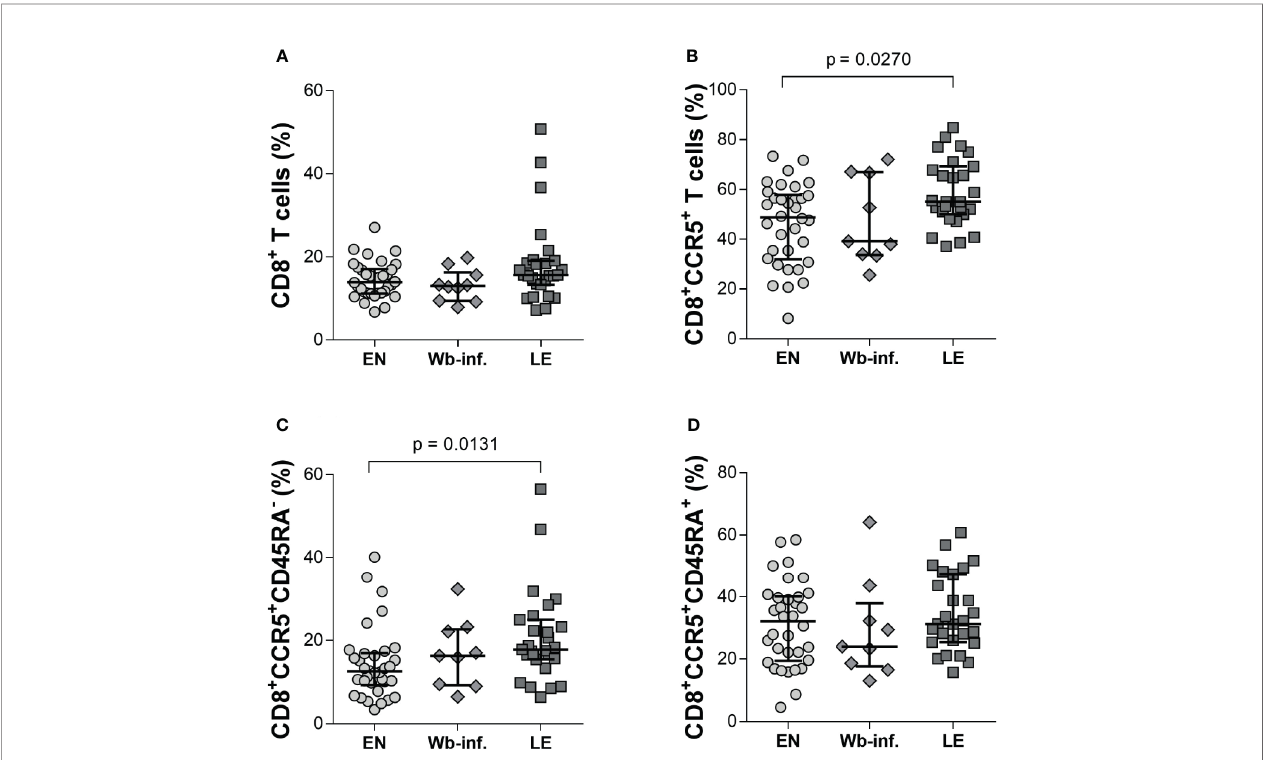
FIGURE 1 | CD8 + T cells from individuals with Wuchereria bancrofti-associated lymphedema present elevated expression of CCR5 + CD45RA - . Frequencies of CD8 + T cells were measured by fl ow cytometry in whole blood samples from cohorts of Wuchereria bancrofti infected (Wb-inf., n = 10) and lymphedema (LE) patients (n = 31) and compared with those from endemic normal (EN) subjects (n = 34) living in the same communities (A) . Cell populations were analyzed according to the applied gating strategy ( Supplementary Figure S1 ). The CD8 + T cells were then further analyzed for expression of CCR5 per se (B) and in conjunction with memory (C) , CD45RA - or naïve (D) , CD45RA + markers. Symbols in graphs show individual data sets with median and IQR. Statistical signi fi cance between the groups was obtained using Kruskal-Wallis followed by Dunn ’ s multiple comparison post hoc